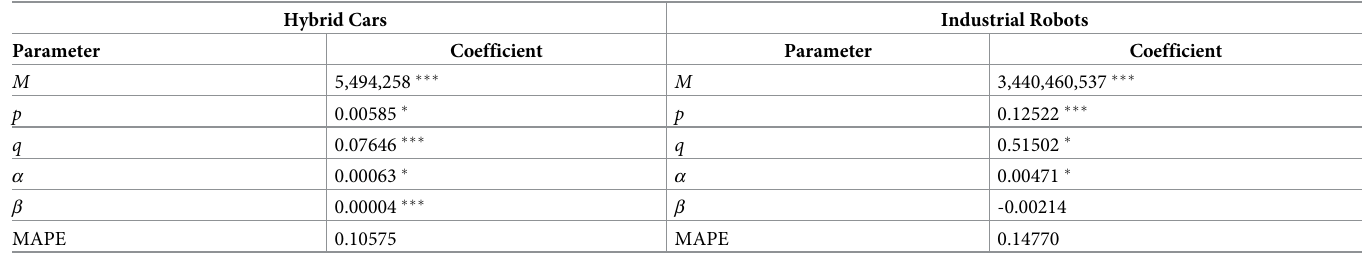
Table 5. Estimation results of modified Bass model using patent citations and web search traffic.